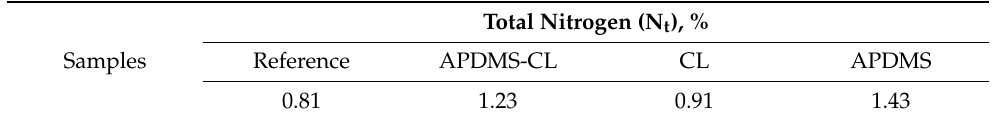
Table 2. Total nitrogen determination after plant removal.